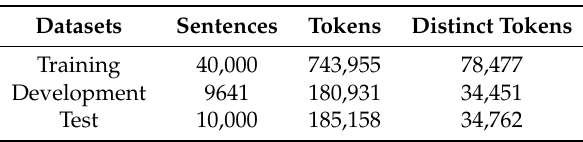
Table 4. Corpora 2